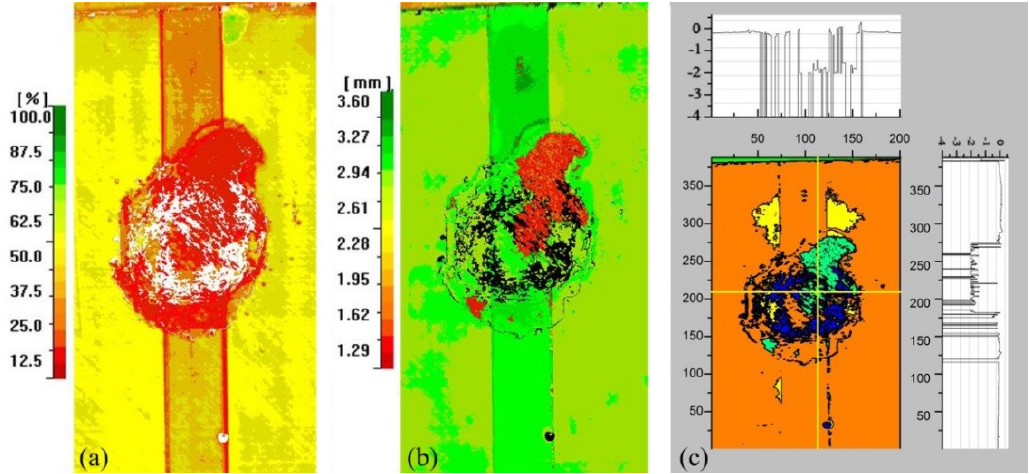
Figure 8. Echo amplitude, echo location, and location data for composite-reinforced panel with a full-sprayed aluminum coating: ( a ) echo amplitude; ( b ) echo location; ( c ) location data (Unit: mm).